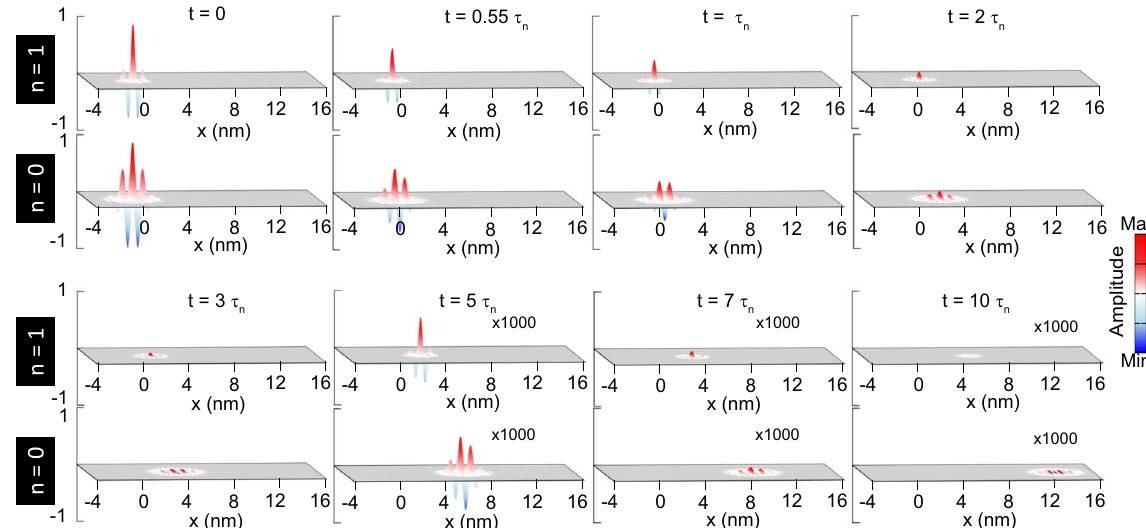
Fig. 8 Real-space evolution of surface and interface magnons in the Co/Fe/Co structure. The evolution of the magnon wave packets in the Co/Fe/Co structure at the point ( q x , q y ) = (0.7, 0), indicated in Fig. 7. Here, q x and q y represent the x and y components of the wavevector. τ n denotes the lifetime of the n th magnon mode and is obtained from the experimental data ( τ n = 2 _ = Γ n , where Γ n represent the intrinsic broadening of the magnon modes, τ 0 = 53 fs and τ 1 = 19 fs). The amplitude of the wave packets after t = 5 τ n is multiplied by 1000 for